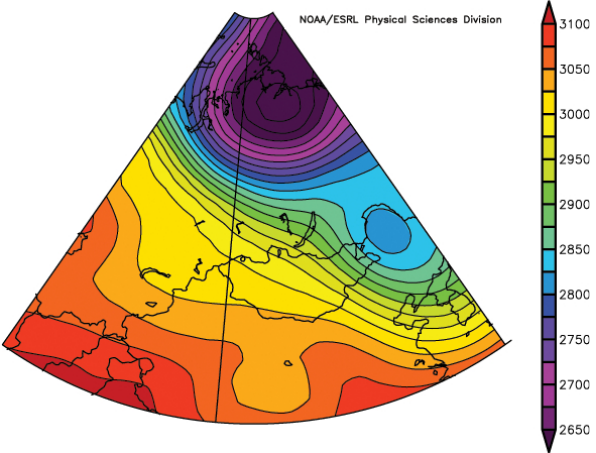
Fig. 18. Mean 700 hPa geopotential height (m) pattern, 2 April 2008. Possible Gobi dust raising event. Plot spans latitudes 40– 85 ◦ N and longitudes 60–130 ◦ W. Mongolia is near the center of the plot, with Lake Baikal just north of Mongolia.